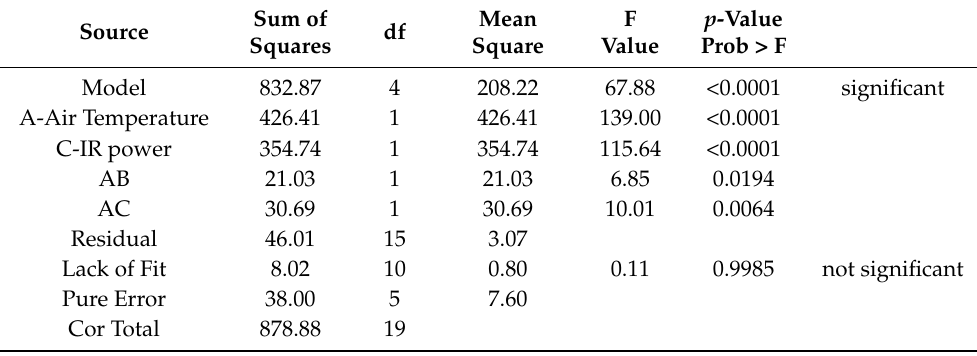
Table 8. Analysis of variance for shrinkage response using